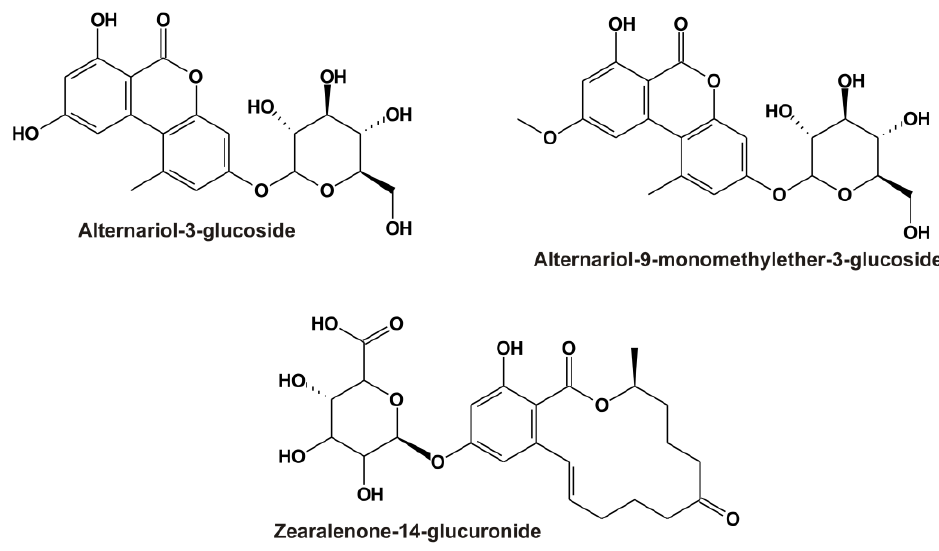
Figure 1. Chemical structures of alternariol-3-glucoside (AG), alternariol-9-monomethylether-3-glucoside (AMG), and zearalenone-14-glucuronide (Z14Glr).